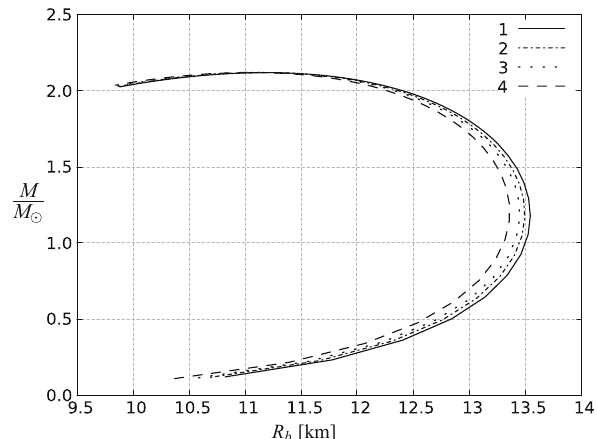
Table 1 The masses and radii of the compact objects with polytropic EoS and central density 1 . 65 × 10 15 g / cm 3 for different values of γ